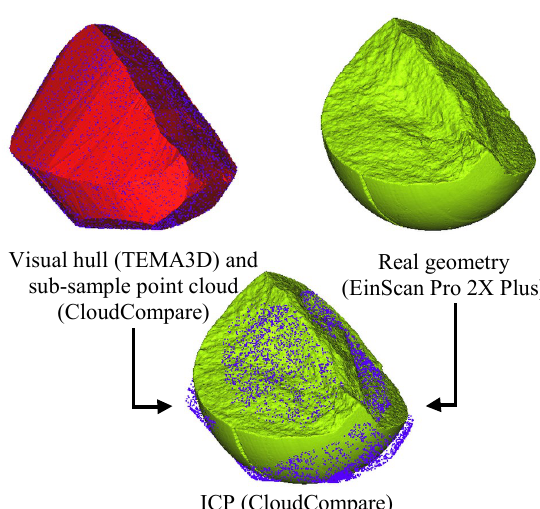
Figure 6. Example of visual hull obtained from TEMA3D and its real geometry representation obtained with the structured light scanner.